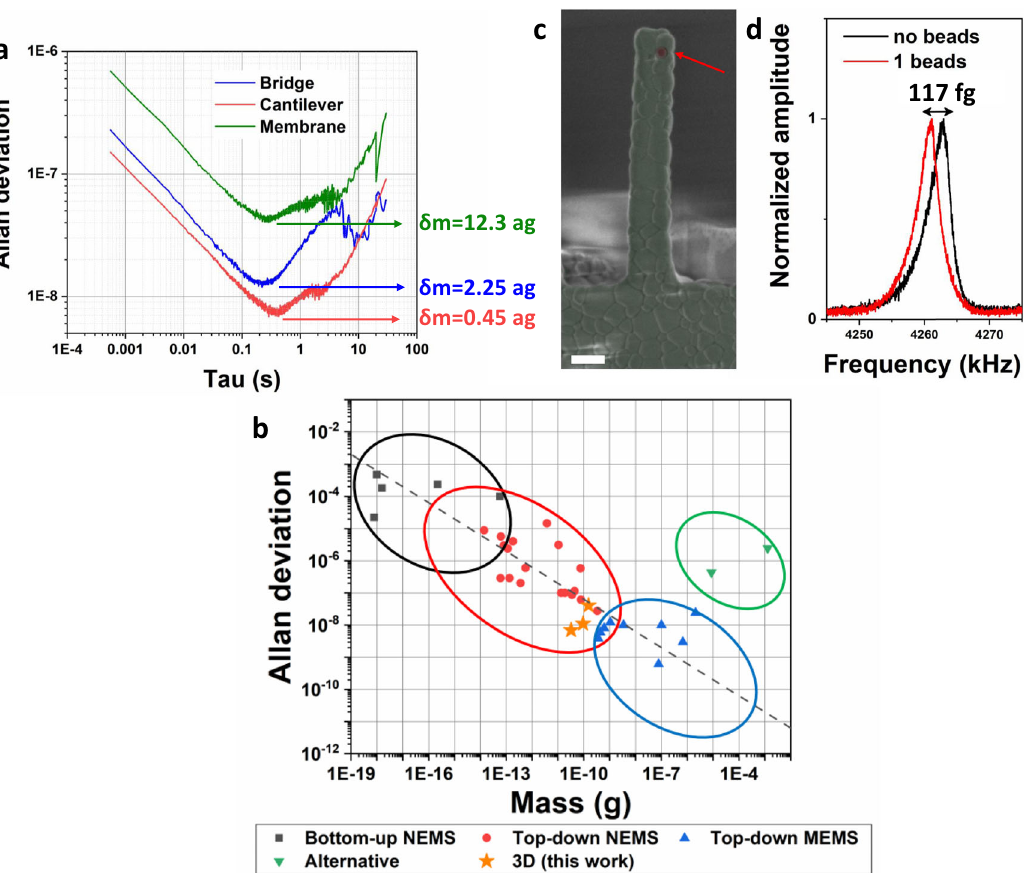
Fig. 6 Frequency stability of 3D printed devices and mass sensing. a Open-loop Allan deviation for the three types of resonators. Minimum detectable mass for each device is computed as δ m = 2 m δ f / f 0 . b Frequency stability of mechanical resonators from literature as function of device mass and fabrication approach. The graph is an integration with our devices (stars) and more recent literature works of the analysis presented by Sansa et al. 45 . Dashed line represents the general trend 10 − 12.2 m − 1/2 reported in ref. 45 . References of literature work are reported in Supplementary Figs. S10, S11, and Supplementary Note 3). c SEM image in